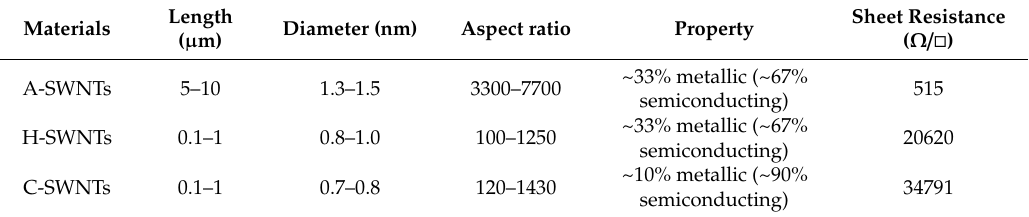
Table 1. Characteristics of various SWNTs: A-SWNTs, H-SWNTs, and